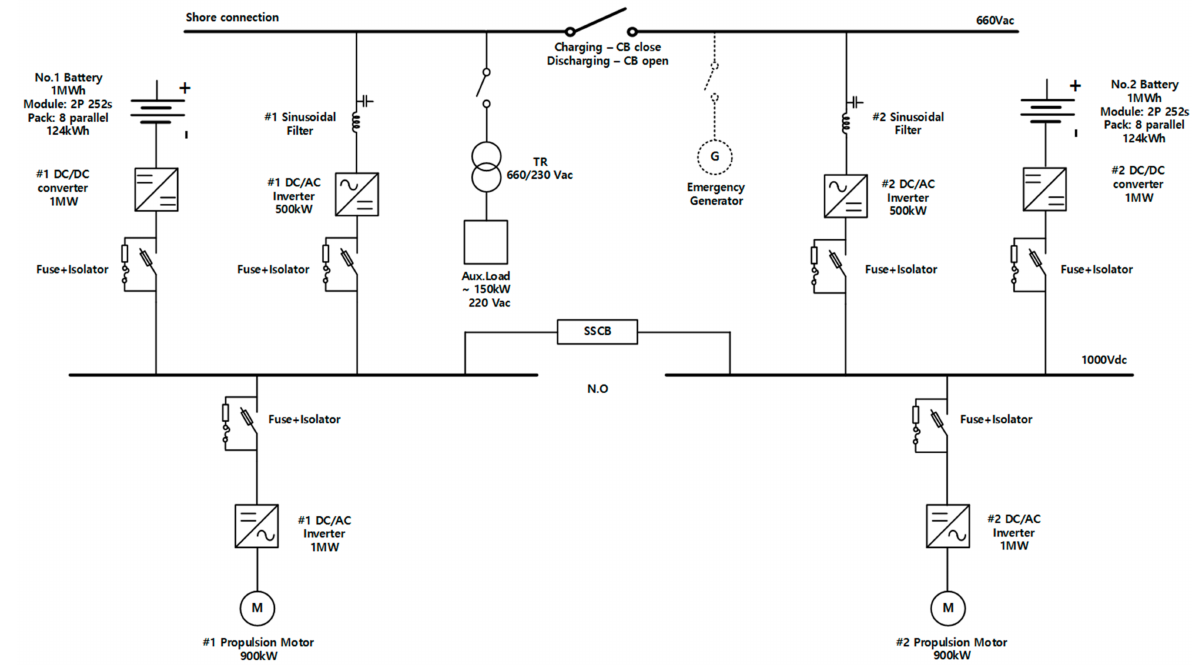
Figure 9. Schematic diagram of the proposed DC distribution